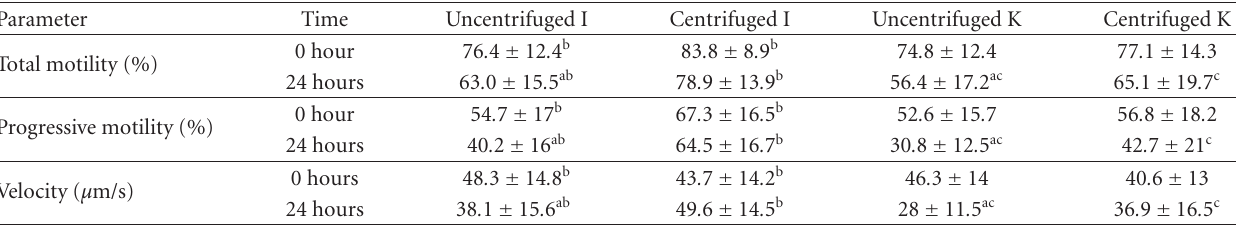
Table 1: Mean ( ± SD) values for sperm kinematics of cool-stored stallion spermatozoa in di ff erent extenders after Single Layer Centrifugation ( n = 45).